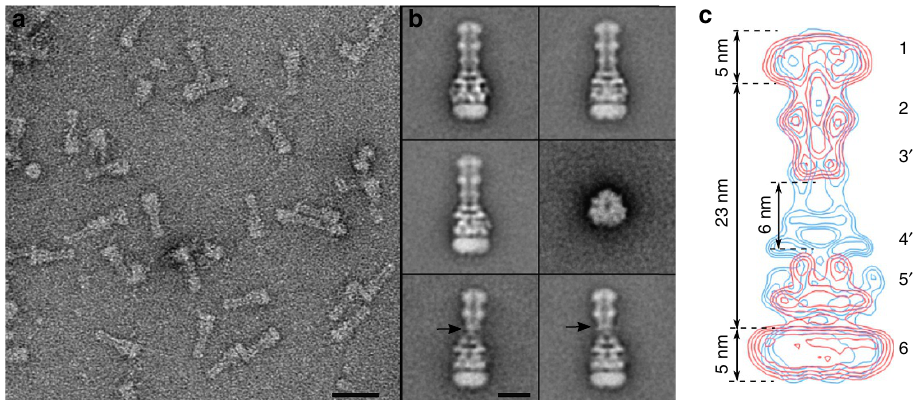
Figure 4 | TEM analysis of tripartite MexAB–OprM assembly. ( a ) Field of view revealing elongated complexes when OprM-ND and MexB-ND were mixed in the presence of MexA. Scale bar, 30nm. ( b ) Gallery of five class average side views of a 33-nm-long tripartite MexAB–OprM complex delineated by two nanodiscs (157, 192, 185, 99, 151 images, respectively) and one top view class average (56 images). Lower row, two average classes of atypical complexes showing faint contacts between OprM and MexAB (black arrows). Scale bar, 10nm. ( c ) Isocontours of MexB–ND and OprM–ND (red) overlaid on isocontours of tripartite complex (blue). Characteristic features are displayed: OprM b -barrel and ND (1); equatorial domain (2), tip of a barrel (3 0 ), MexB funnel (4 0 ) and porter (5 0 ) domains anchored to ND (6). The remaining blue densities correspond to MexA that linked OprM to MexB and interacts with the domains marked with ( 0 ). The tripartite assembly ND (6) has a smaller size compared with ND of MexB probably because of the detergent carried with MexA that may extract some